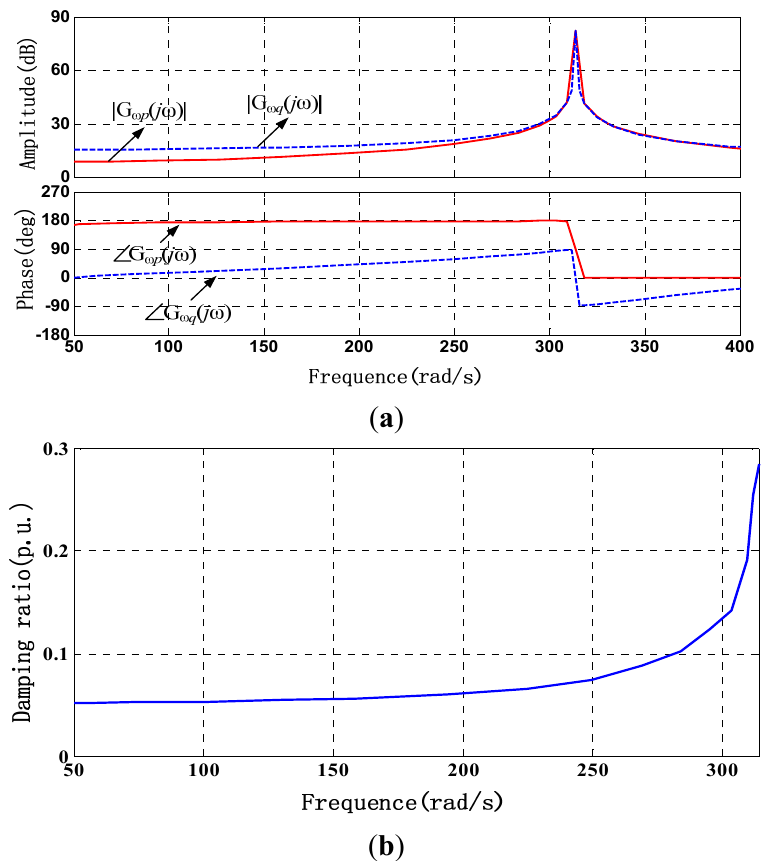
Figure 8. Characteristics of the transfer function with auxiliary damping control, ( a ) amplitude phase-frequency characteristic curve; ( b ) damping ratio